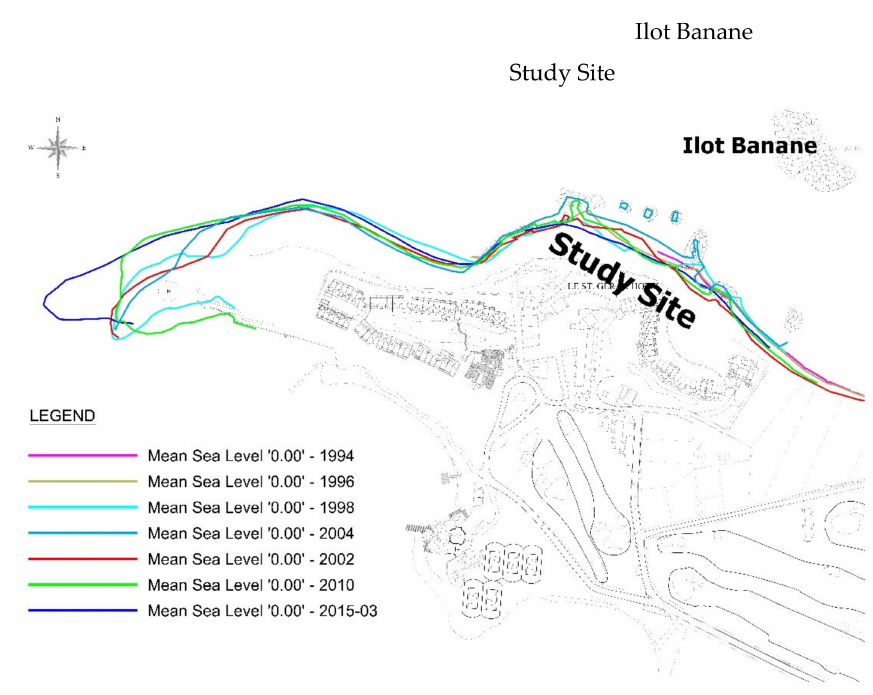
Figure 3. Mean sea level from beach profile surveys over the period from 1994 to 2015 at the One&Only Resort in St Geran,